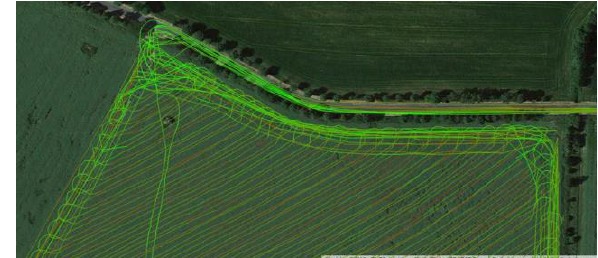
Figure 1. Vegetation index computed from Landsat 8 satellite images used to capture the dynamics of vegetation growth. Yellow colour means vegetation under stress (in this figure rural areas within Brno city) while blue colour means growing vegetation with the highest possible density of green leaves.